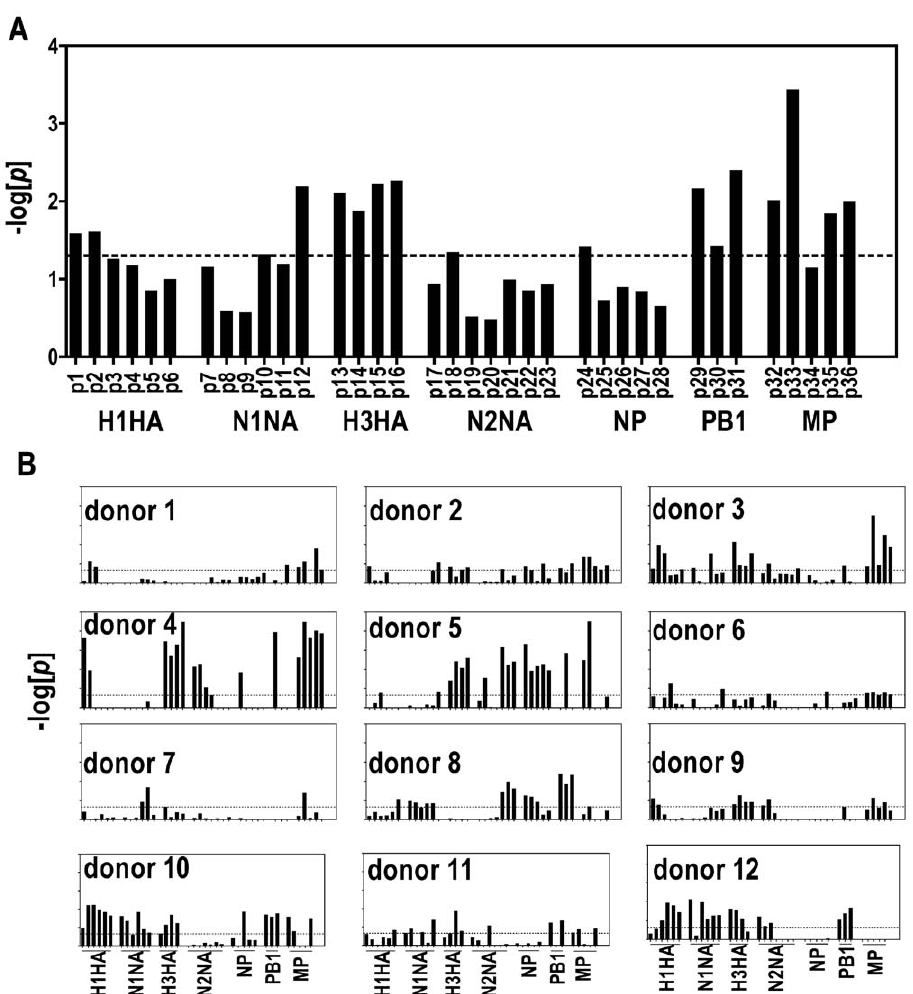
Figure 4. Results of using peptide:MHC/IFNgamma microarray to measure 36 different influenza A specific CD4 T cell responses. (A)The average score for each influenza A peptide ( n=12 ); (B) Individual plot for each DR0401 donor. Dotted lines represent the 2 log[ p ] score equivalent to 95% confidence limit ( p=0.05 ) to further distinguish ambiguous score ( p . 0.05 ) from less ambiguous score ( p , 0.05 ).